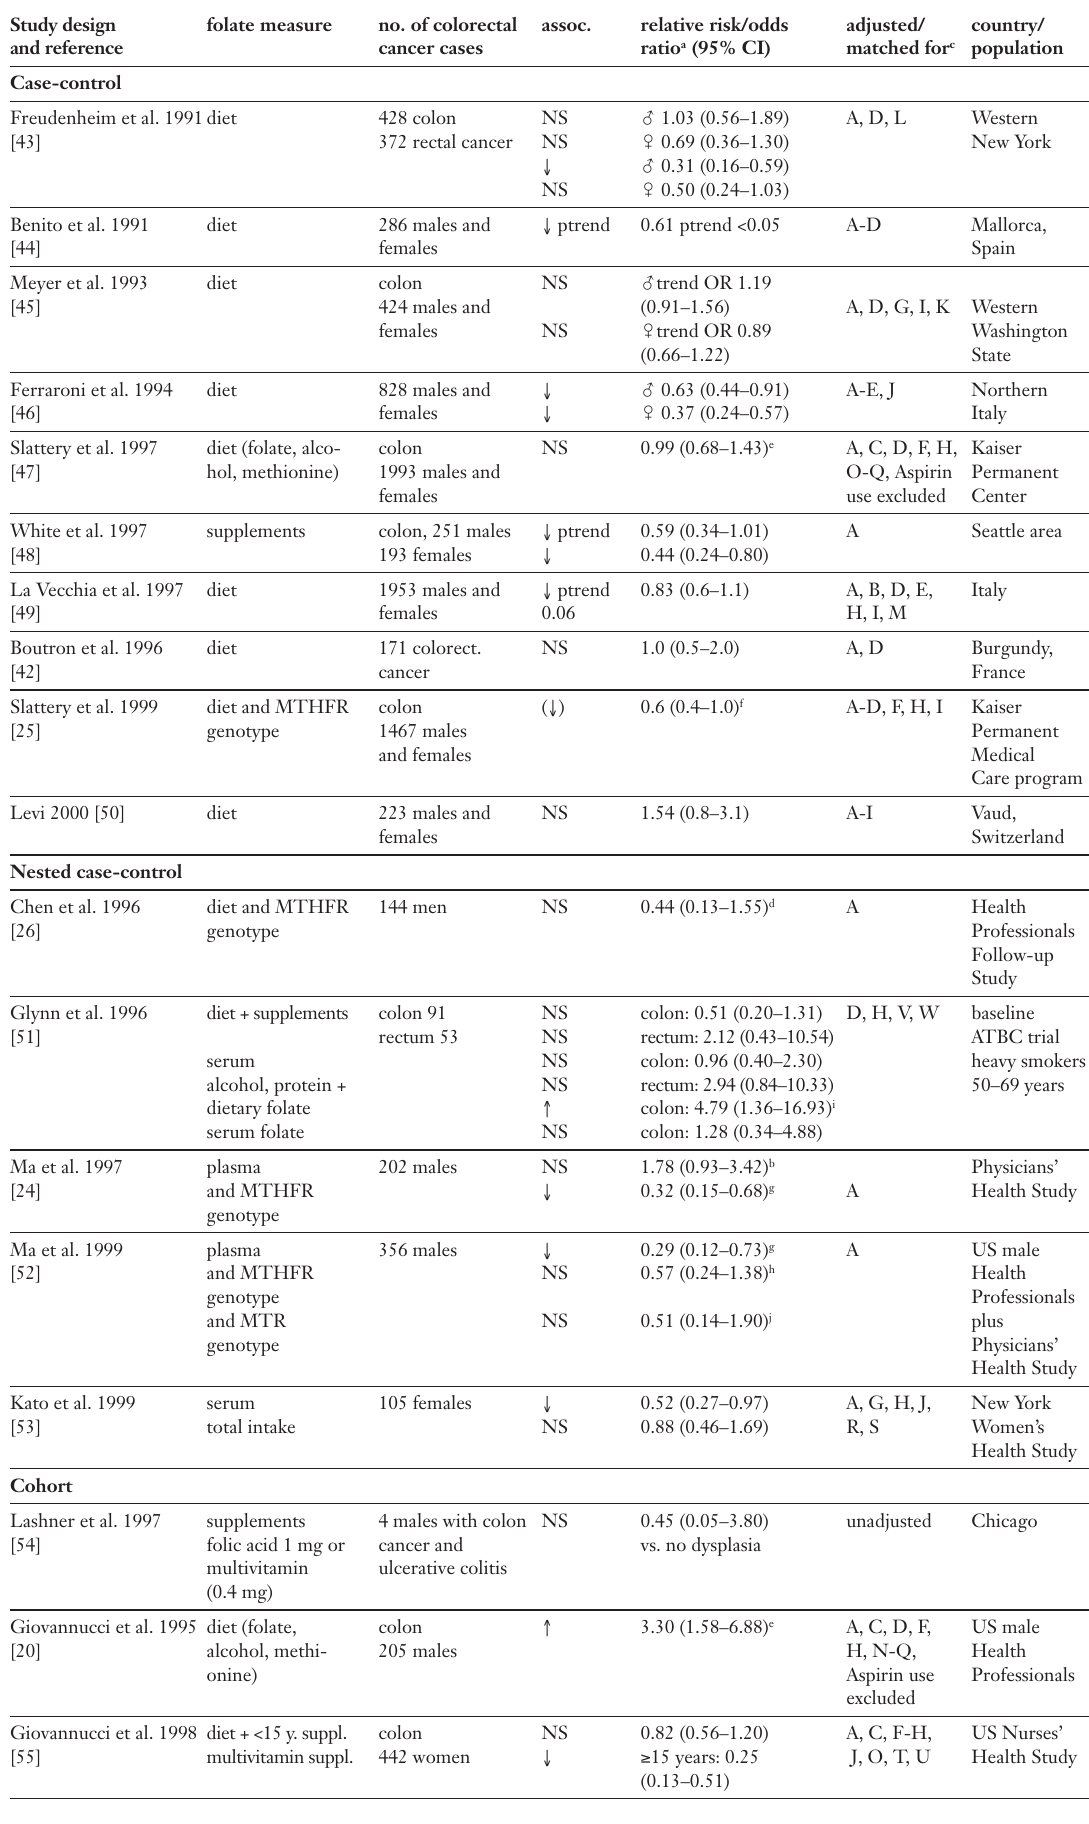
Folate and risk of colorectal